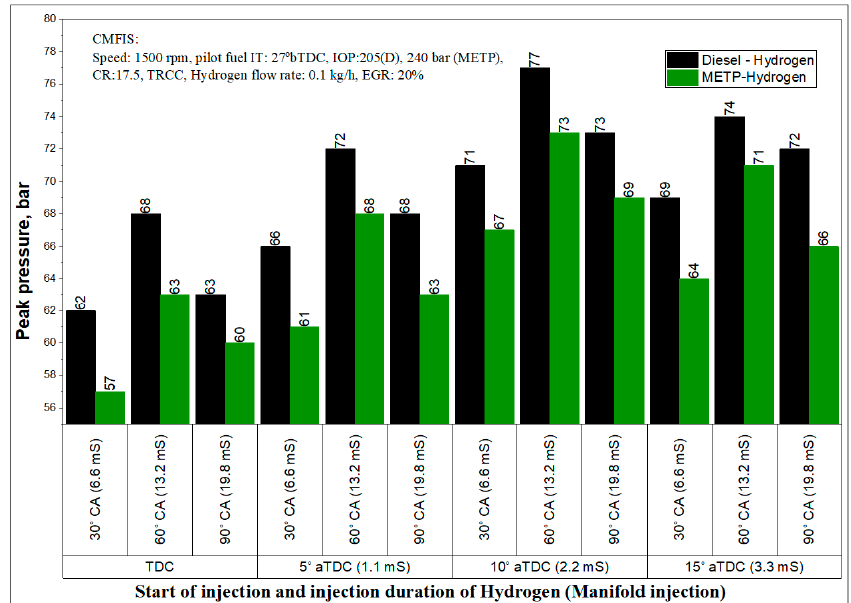
Figure 17. Peak pressure for manifold injection of hydrogen in CMFIS based dual-fuel engine.